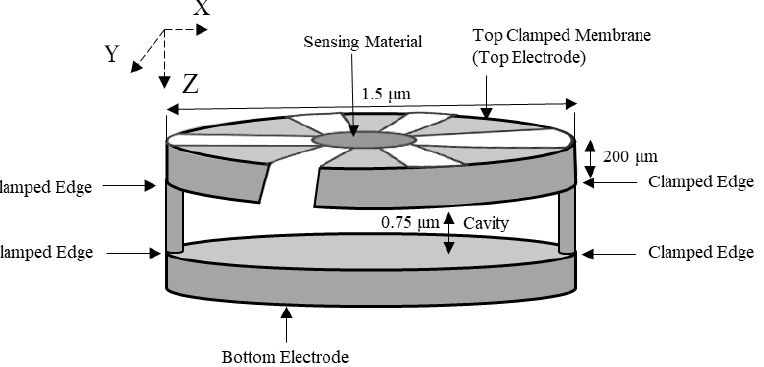
Figure 22. Schematic view of a wheel capacitive clamped membrane structure (image not to scale).